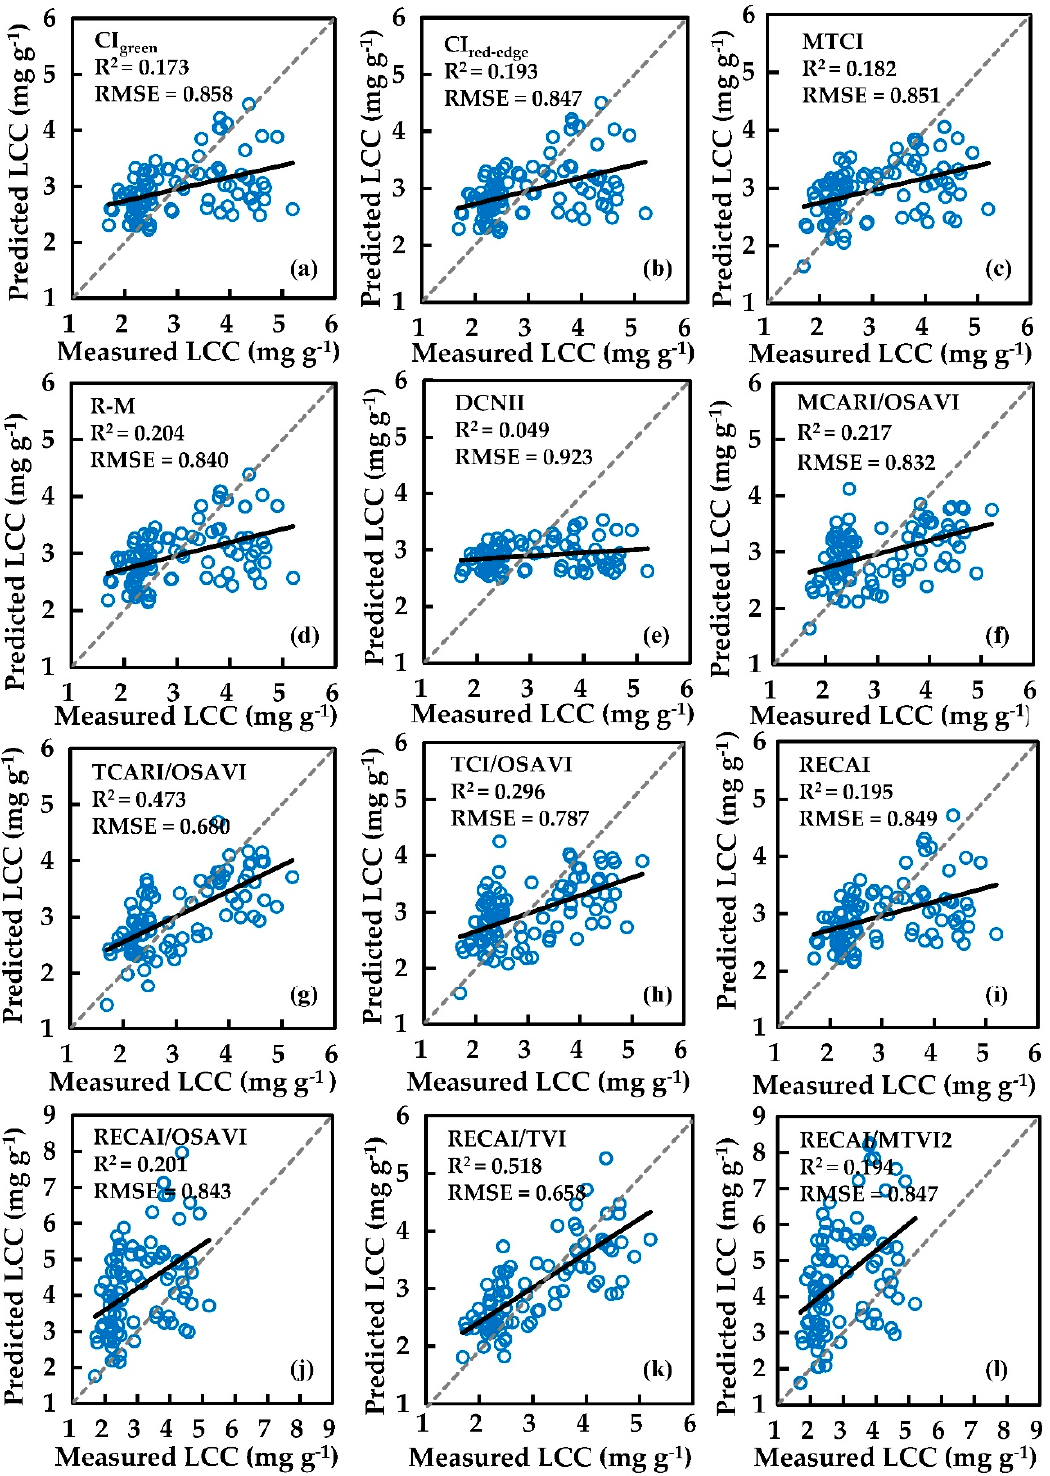
Figure 4. ( a – l ) The validation scatterplots between measured and predicted LCC by CI green , CI red-edge , MTCI, R-M, DCNI I, MCARI / OSAVI, TCARI / OSAVI, TCI / OSAVI, RECAI, RECAI / OSAVI, RECAI / TVI, and RECAI / MTVI2 for the dataset ( n = 91), respectively.